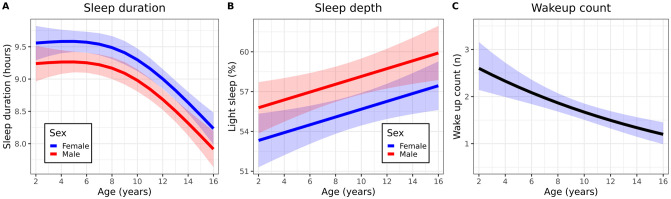
Accelerometer-derived sleep parameters.A: mean (95% CI) sleep duration stratified by sex. B: mean (95% CI) sleep depth stratified by sex. C: mean (95% CI) wakeup count.